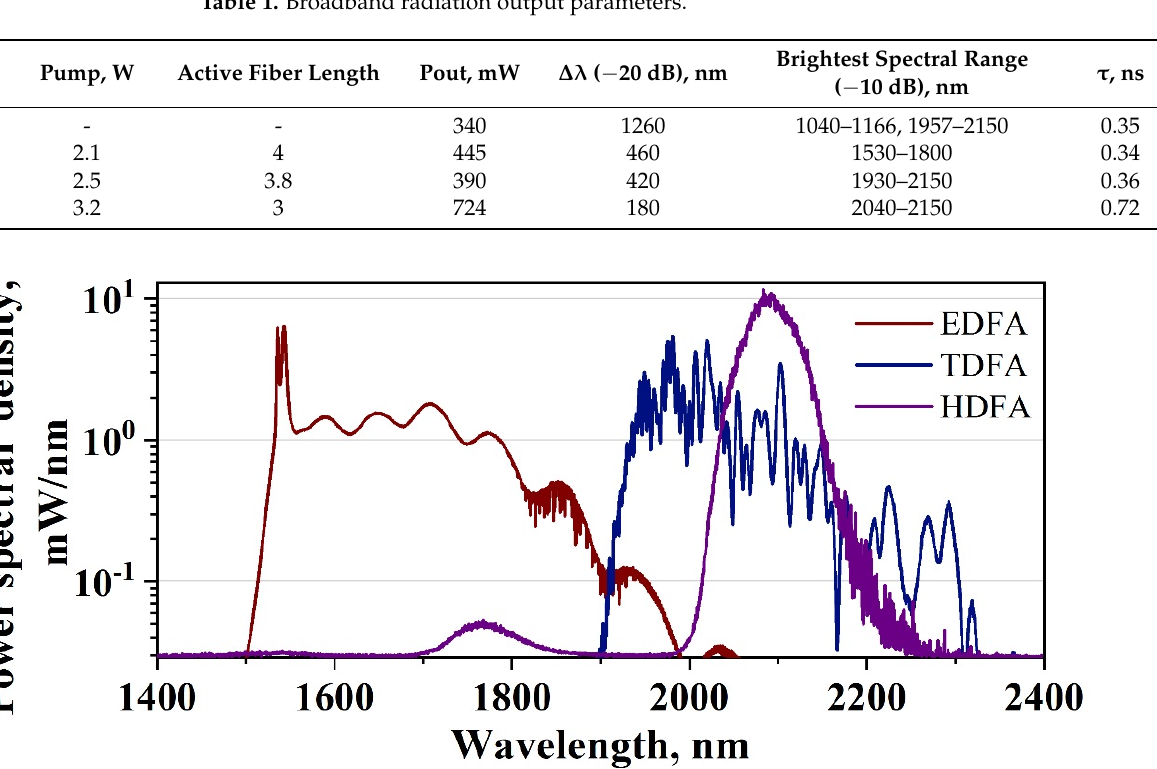
Figure 6. Comparison of obtained spectra. Output optical spectra for all used FAs are shown with the power spectral density. Each one corresponded to the maximum obtained power. Table 1. Broadband radiation output parameters.